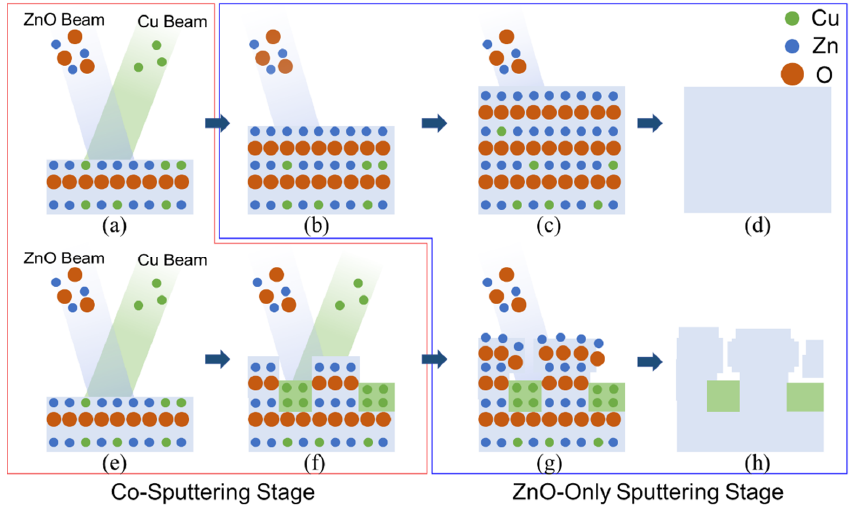
Figure 5. Crystal growth of co-sputtered Cu-ZnO thin films synthesized with ( a – d ) short and ( e – h ) long co-sputtering periods. With a short co-sputtering period, ( a ) no separate Cu structure forms, ( b ) ZnO particles are attached, and ( c ) internal di ff usion occurs during the ZnO-only sputtering step. Finally, ( d ) a uniform Cu-ZnO crystal grows. With a longer co-sputtering period, ( e ) a Cu-ZnO film forms, and ( f ) a separate Cu structure grows and covers the surface during the co-sputtering stage.